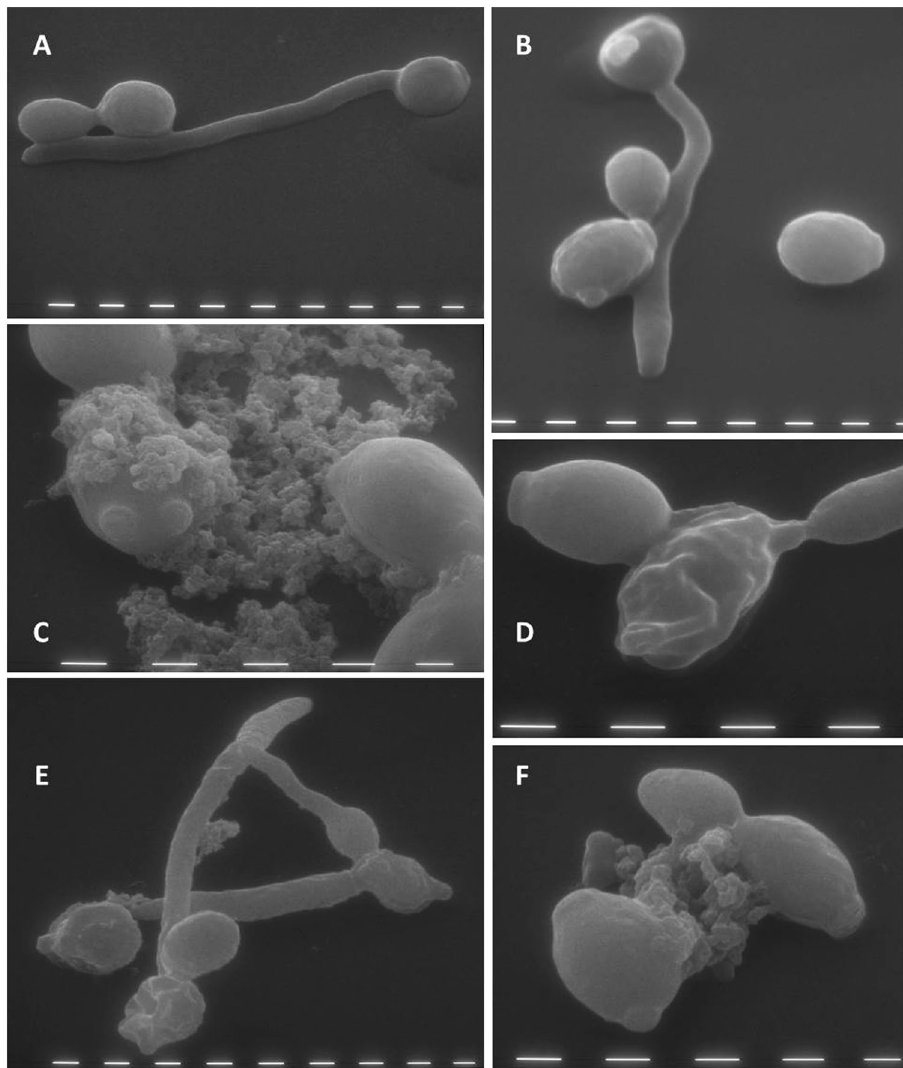
Figure 6. Scanning electron microscopy of Candida albicans cells treated with L12P and L18R peptides. Approximately 4 × 10 5 yeast cells were incubated without (panels A and B, controls) or with the selected peptides (125 μ g/ml) (panels C and D, cells treated with peptide L12P; panels E and F, cells treated with peptide L18R) for 60 min. Masses of debris and cell leakage (panels C, E, F), and gross alterations in cell surface (panels D and E) were observed after treatment with both peptides. Bar: 1 μ